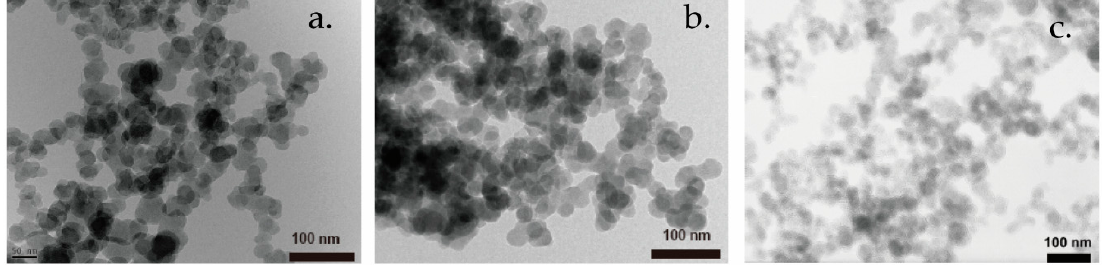
Figure 1. TEM images of soot. ( a ) Printex-U Carbon Black (CB); ( b ) Flame soot FS100; ( c ) Engine soot (DS).